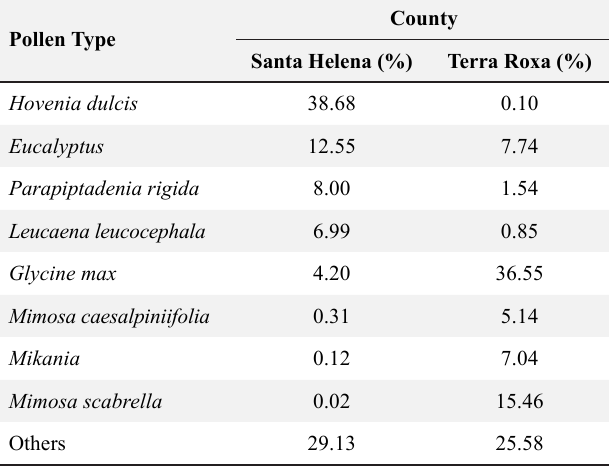
Table 3. Percentage of the main pollen types occurring in total samples of honey from Santa Helena and Terra Roxa (PR), 2008/2009 harvest.